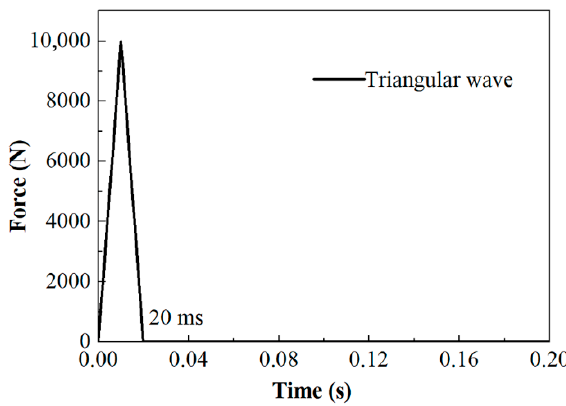
Figure 4. Illustration of the external transient impact.